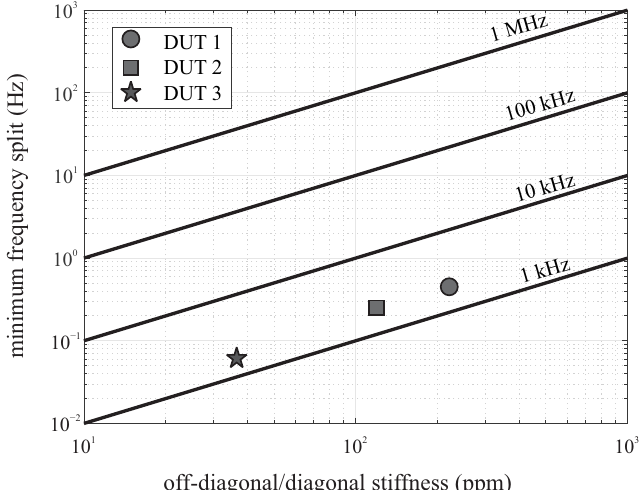
Figure 12. Minimum of frequency split ( ∆ f ) between drive and sense modes as a function of off-diagonal stiffness. Straight lines represent different drive oscillation resonant